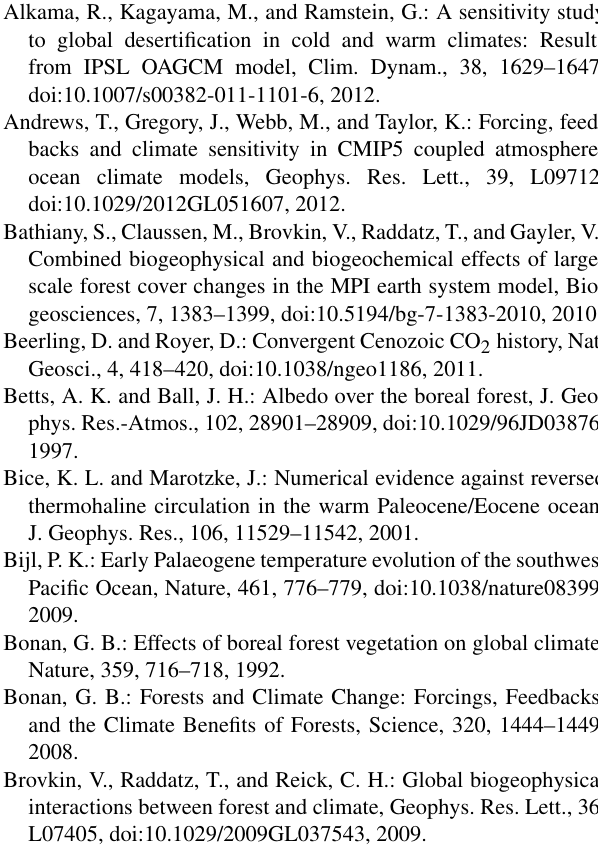
Figure 12. Net feedback parameter and its single components for the comparison of the forest world to the dark desert world. The hatched and the plain bars show the feedback parameters for the pre-industrial climate and the early Eocene climate, respectively. The error bars refer to the 95% confidence